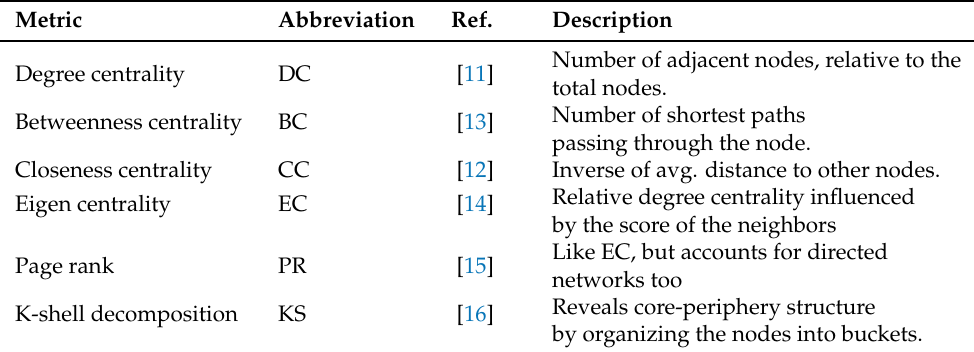
Table 1. Overview of node centrality